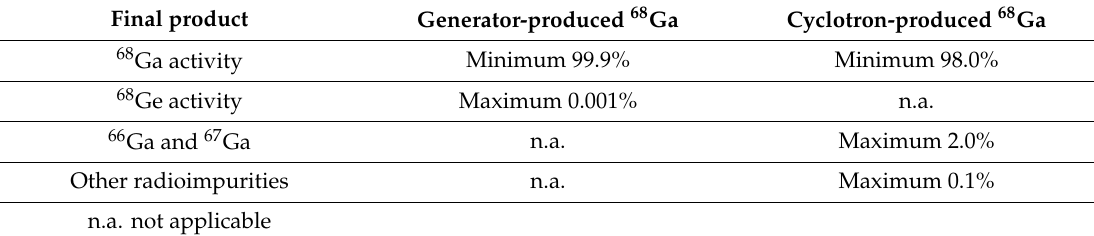
Table 5. Radionuclidic specifications based on the European Pharmacopoeia for generator and cyclotron-produced 68 Ga [table adapted from